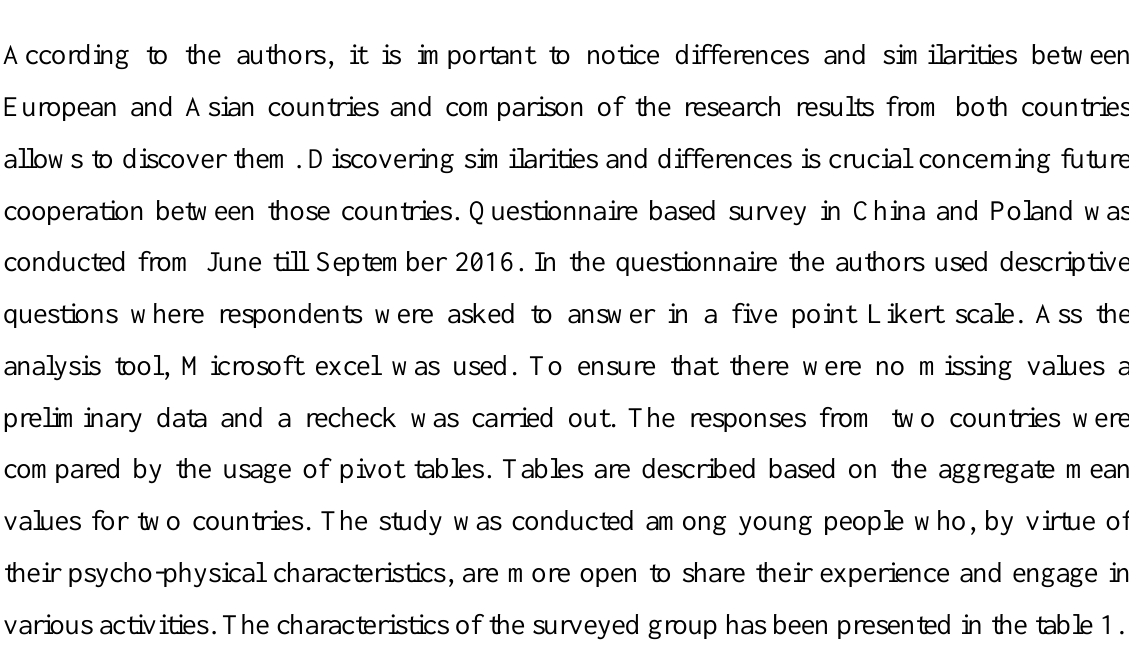
Table 1: Characteristics of the surveyed group participating in research in Poland